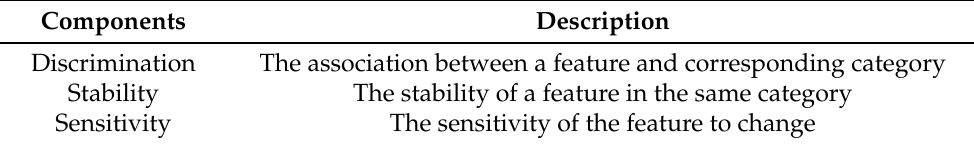
Table 3. The components of